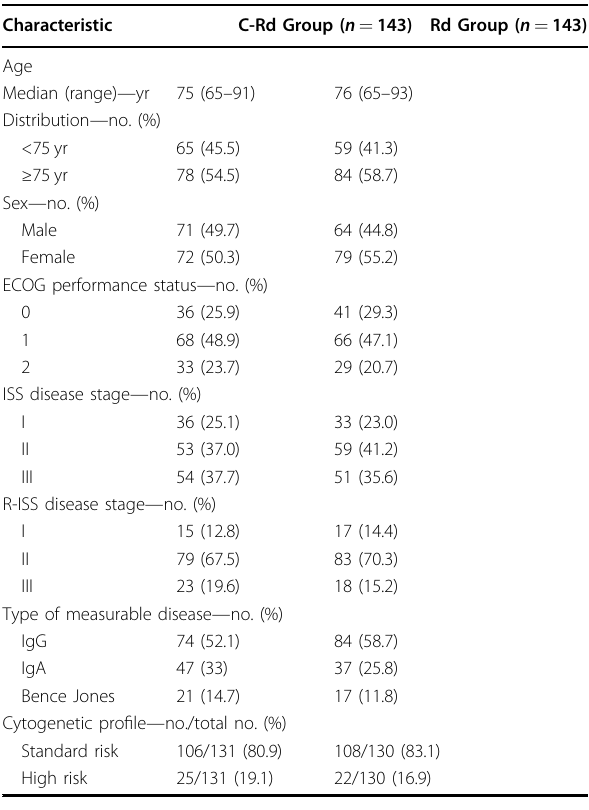
Table 1 Demographic and clinical characteristics in the intention-to-treat population at